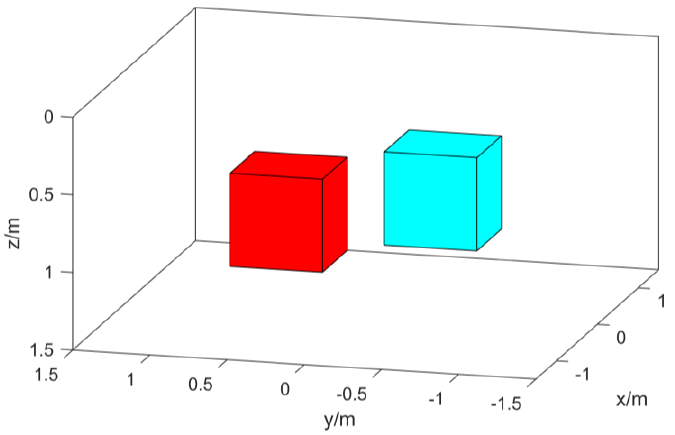
Figure 3. Schematic diagram of the simulation model.